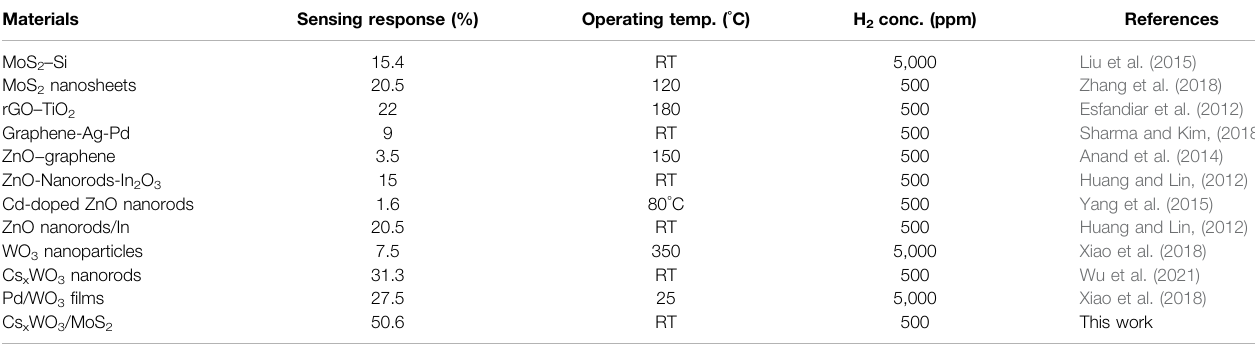
TABLE 1 | Comparison of H 2 sensing properties of different metal oxide-based gas sensors. Materials Sensing response